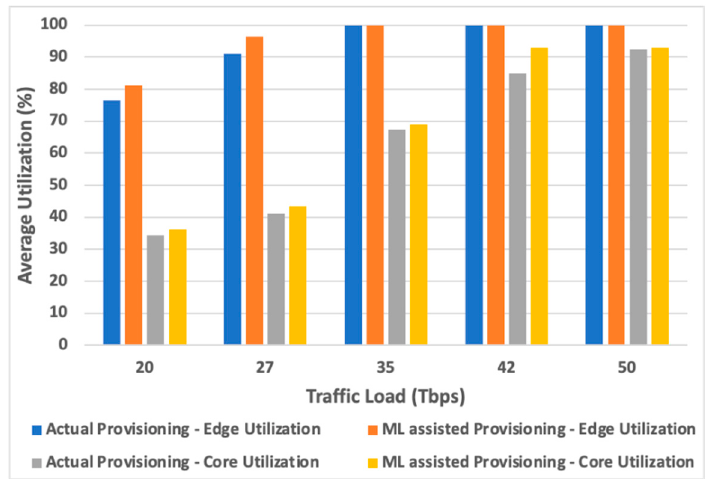
Figure 9. Average utilization of the processing edge and core nodes in the actual and ML assisted provisioning scenarios for different traffic loads.